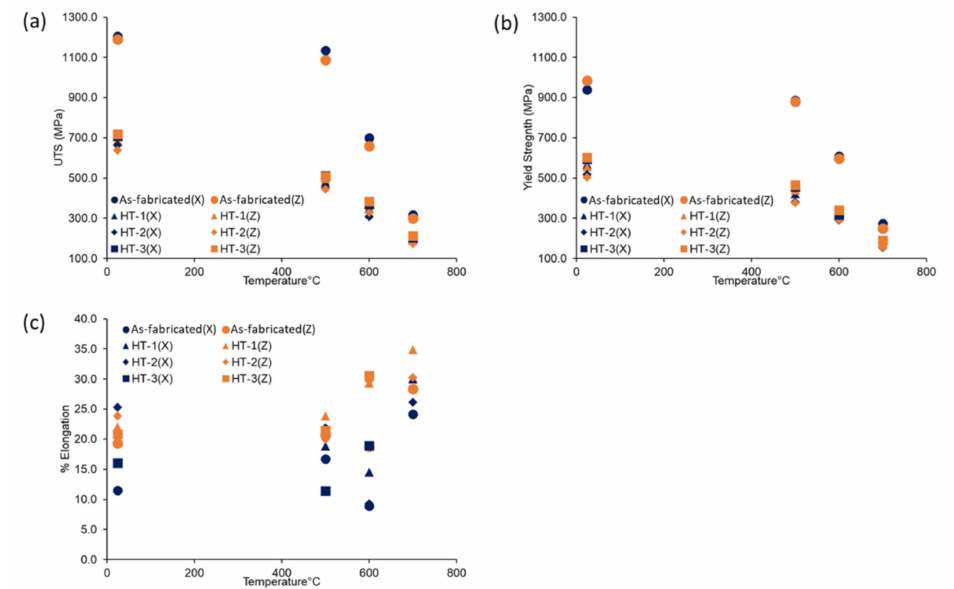
Figure 16. Mechanical properties for tensile test samples at different temperatures in all conditions perpendicular to the build direction (X) and in-build direction (Z). Ultimate Tensile Strength ( a ), Yield Strength ( b ), and Elongation in % ( c ) were plotted against the test temperature.